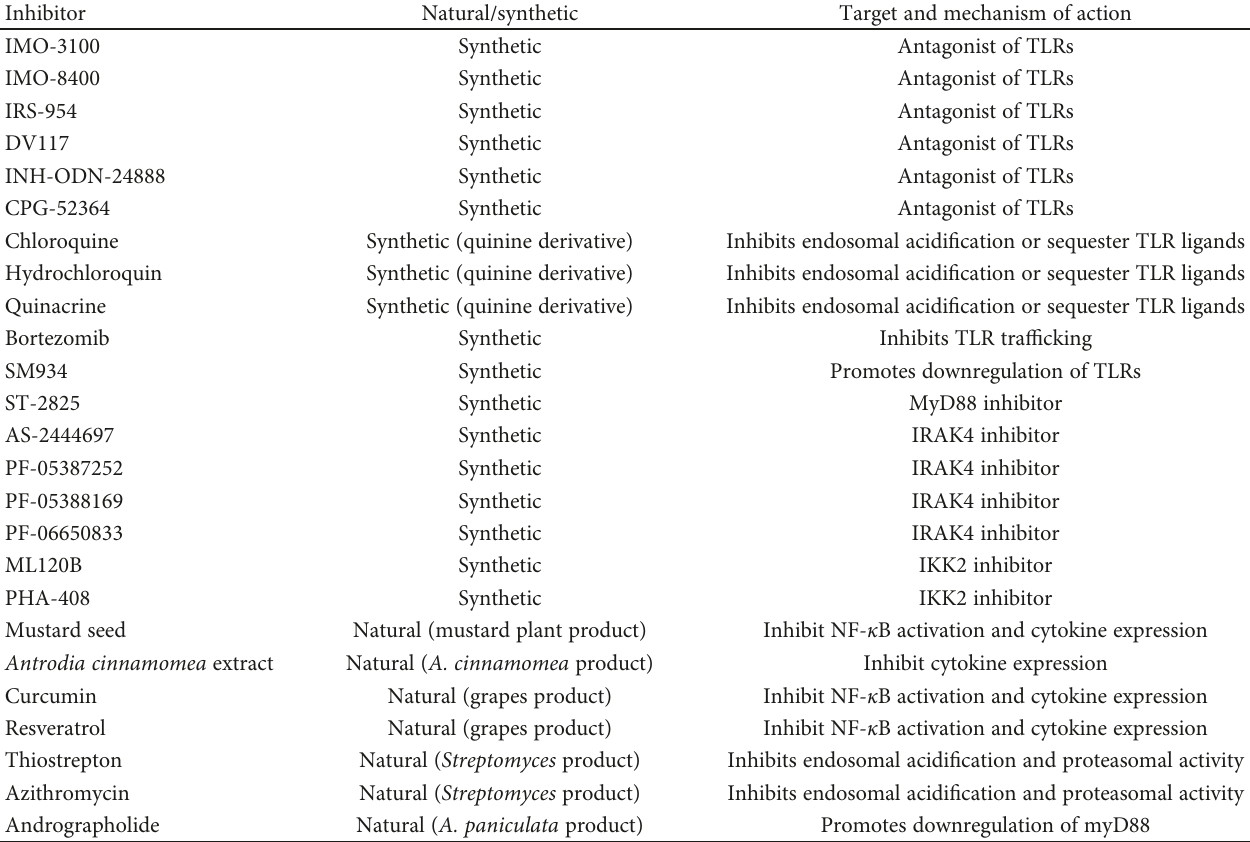
Table 1: Inhibitors for endosomal TLR-mediated in fl